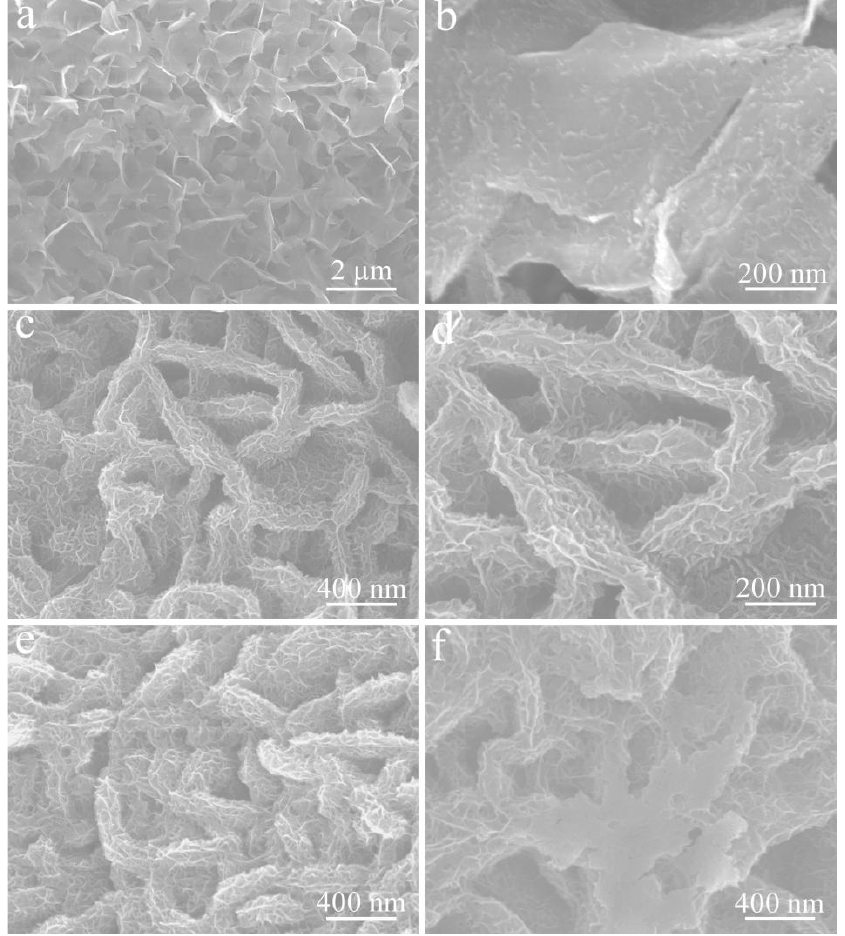
Figure 5. FE-SEM images of Ni 3 S 2 electrodeposited on Co(OH) 2 /NF for different potentiostatic dep- osition durations: ( a , b ) S-1, ( c , d ) S-10, ( e ) S-20 and ( f ) S-40. deposition durations: ( a , b ) S-1, ( c , d ) S-10, ( e ) S-20 and ( f )